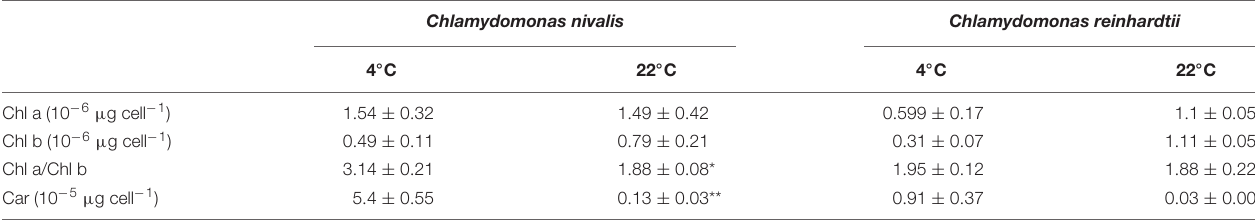
TABLE 1 | The pigment contents of C. nivalis and C. reinhardtii measured at 22 and 4 ◦